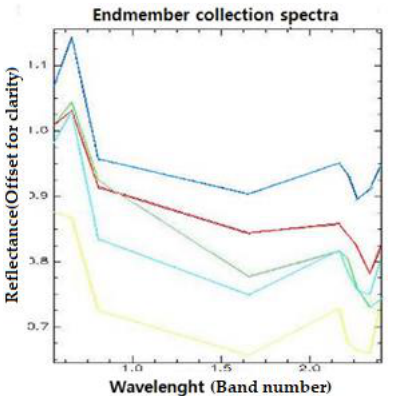
Figure 16. Reflectance spectra of harzburgite exposed at the Khoy ophiolite zone: spectra resampled to ASTER VNIR–SWIR band passes.